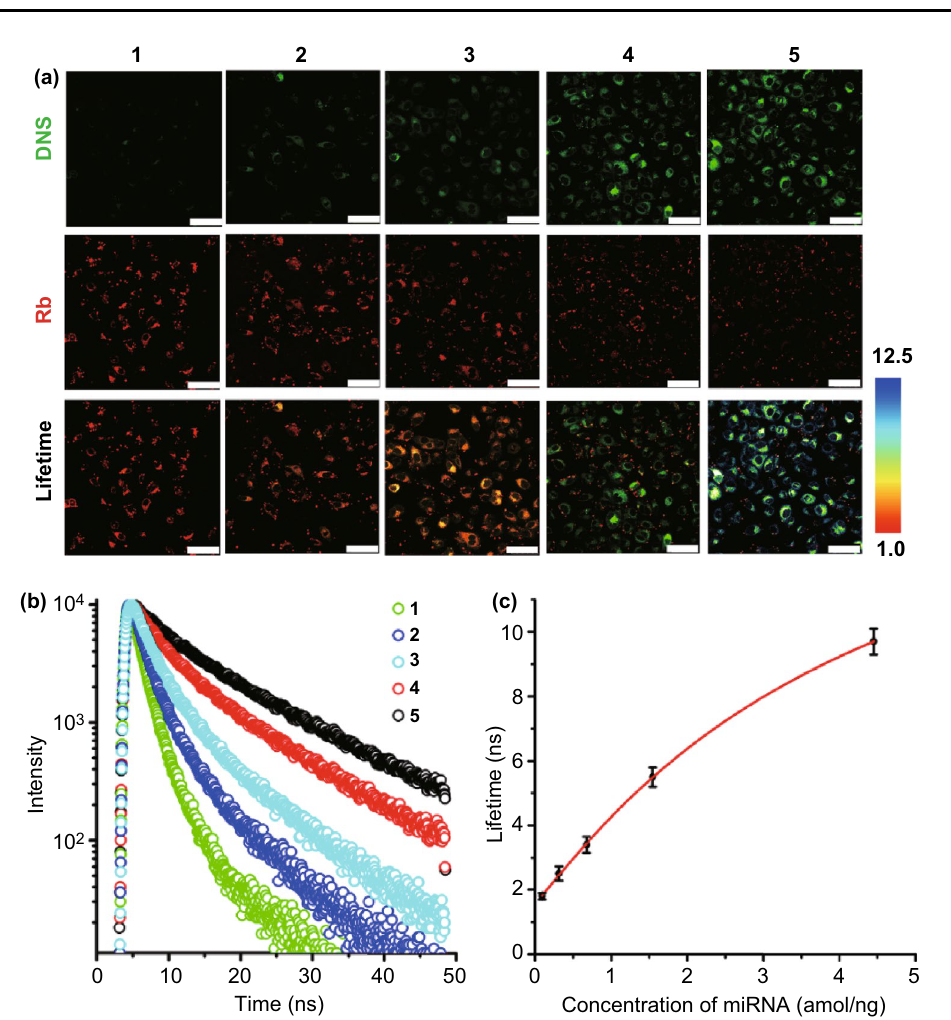
Fig. 4 sPPDN for miR-210 detection in living cells. a Confocal images and fluorescence lifetime images of H1299 cancer cells with different amounts of miR-210: Columns 1 and 2 were transfected with antisense sequences of miR-210, column 3 was not transfected, and columns 4 and 5 were transfected with both miR-210. Scale bars: 50 μm. b Relative fluorescence lifetime decay curves of DNS in H1299 cancer cells with dif- ferent amounts of miR-210. c The lifetime for different concentrations of intracellular miR-210. The excitation wavelength was light irradiation (10 mW cm −2 , 5 min). Signals from the donor and the acceptor were recorded at 510 and 580 nm,